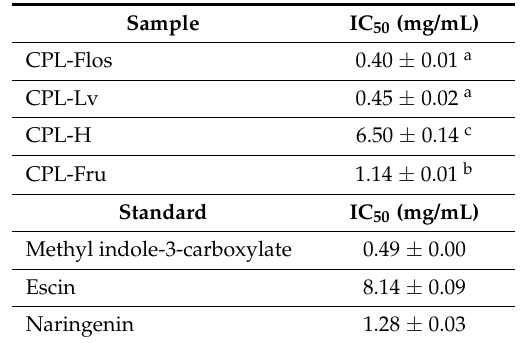
Table 4. Anti ‐ hyaluronidase potential of R. rugosa CPL. Results expressed as mean IC 50 values ± SD ( n = 3). Abbreviations like in Table 2.